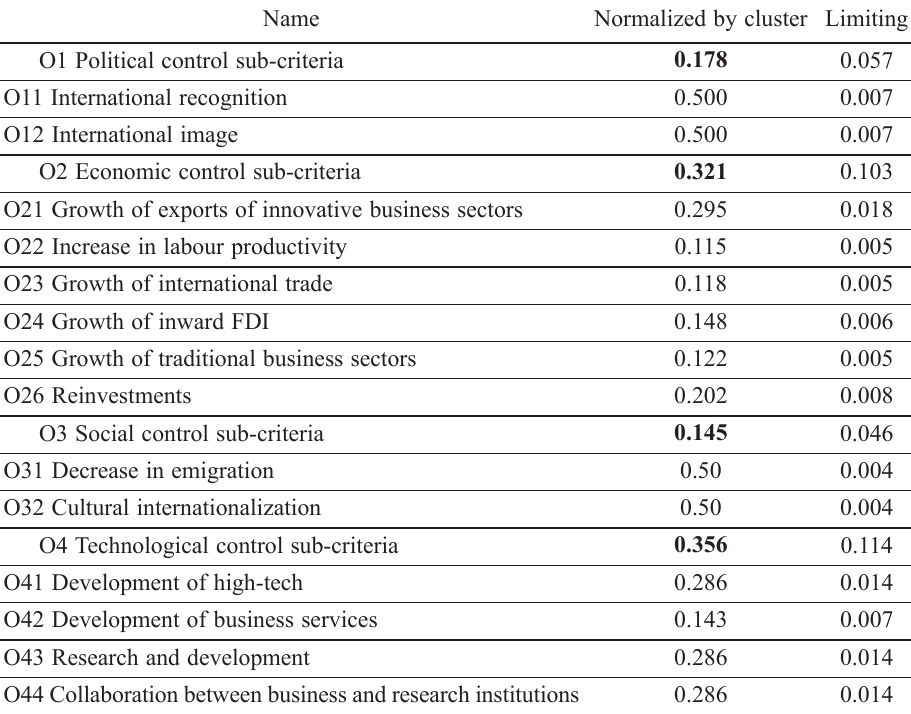
Table 7. Priorities of the elements in the opportunity sub-network Name Normalized by cluster